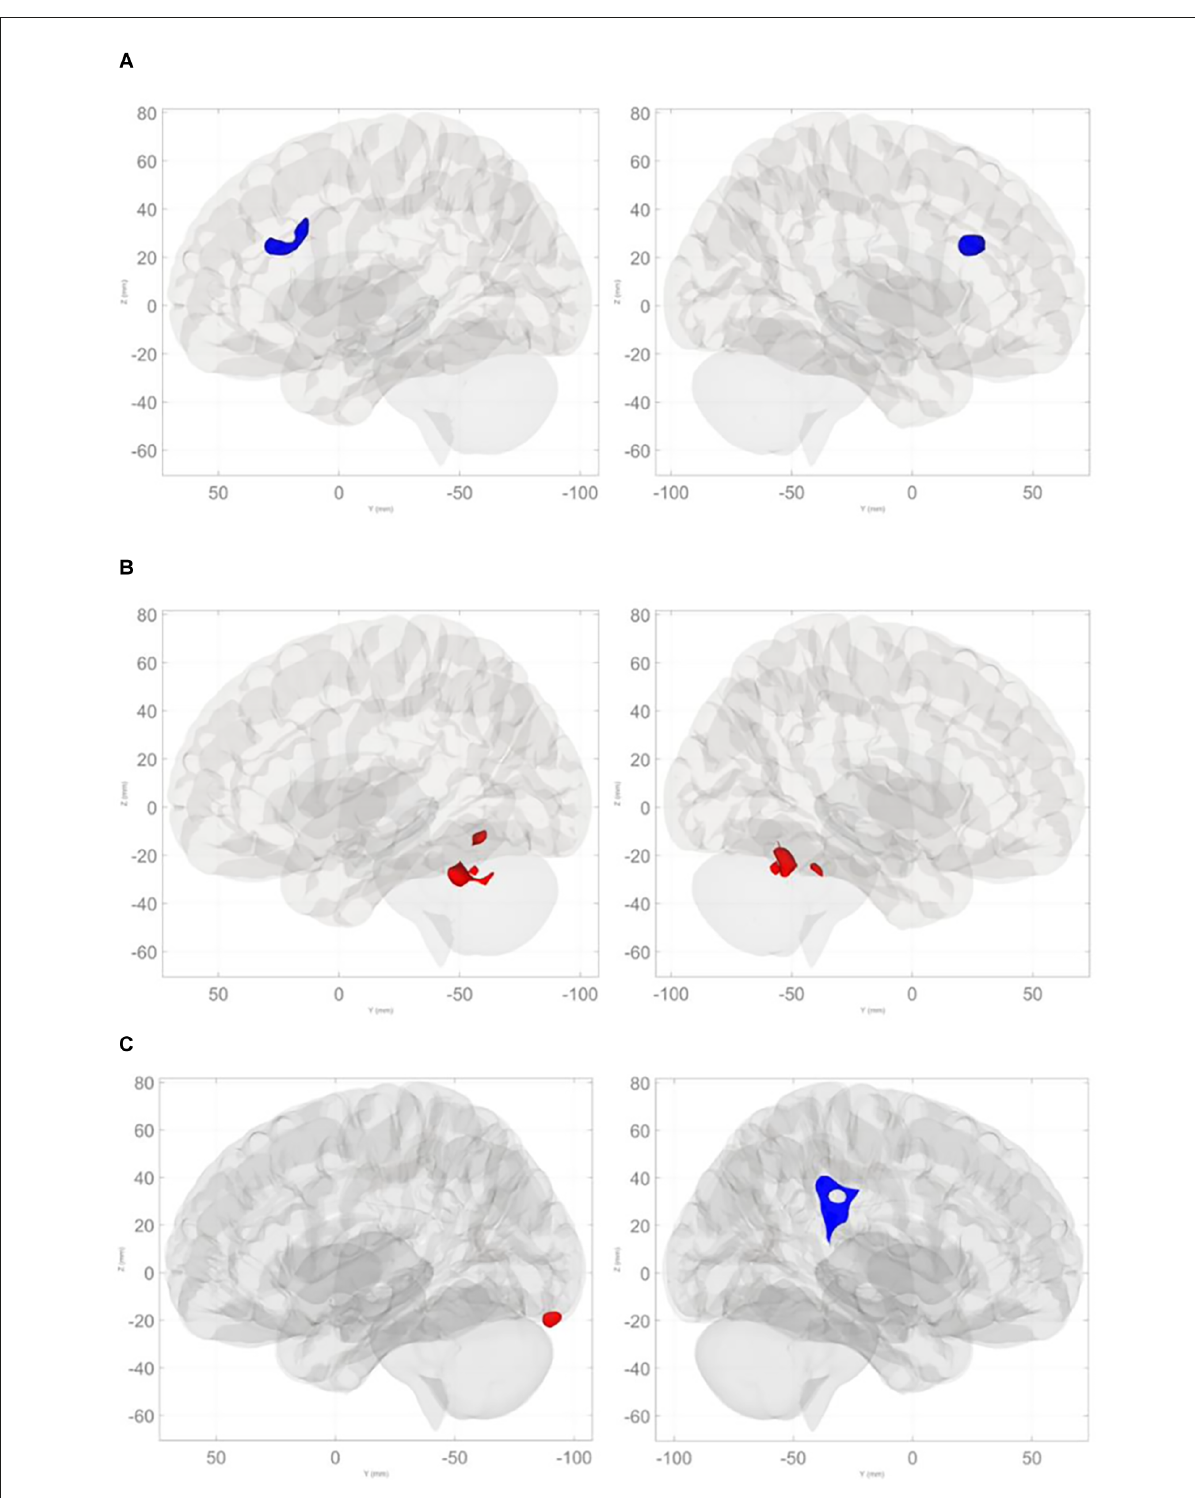
FIGURE3 (A) Negative relationships between command total digit misplacement and basal nucleus of Meynert connectivity with the anterior cingulate cortex. (B) Positive relationships between command total digit misplacement and basal nucleus of Meynert connectivity with cerebellum (anterior lobe, superior posterior lobe, and vermis). (C) Negative relationships between command total completion time and basal nucleus of Meynert connectivity with right supramarginal gyrus and contiguous regions, and positive associations with left occipital pole and the left superior posterior lobe of the